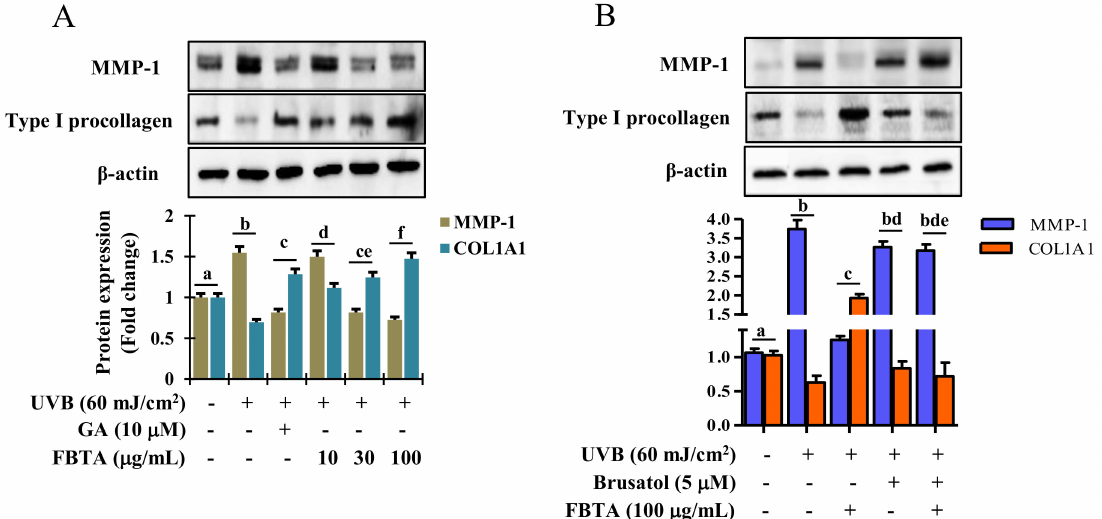
Figure 7. Effects of FBTA on matrix metalloproteinases (MMP)-1 and type I procollagen expression in UVB-stimulated HaCaT cells. The cells were pretreated with FBTA for 24 h, followed by UVB-irradiation. ( A ) MMP-1 and type I procollagen proteins were quantified by immunoblotting. The different letters of each column indicate significance ( p < 0.05); ( B ) Cells were treated with brusatol for 30 min, followed by FBTA treatment (f.c. 100 µ g/mL) for 24 h and were then subjected to UVB insult; the expressions of MMP-1 and type I procollagen were then analyzed by immunoblotting. Densitometric analysis was carried out to quantify the band intensity by β -actin normalization. The different letters of each column indicate significance ( p < 0.05). Different letters (a, b, c, d, f, ce, bd, bde) are denoted as the statistical